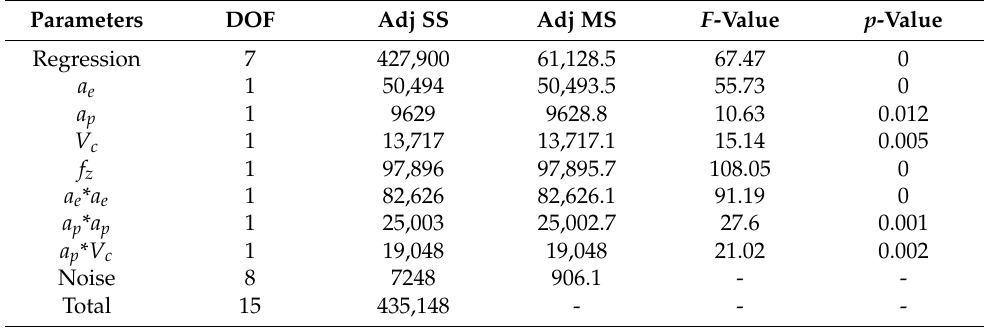
Figure 5. Experimental data [L 16 (4 4 )] and fitting results of maximum cutting force F . Table 3. ANOVA for maximum cutting force.